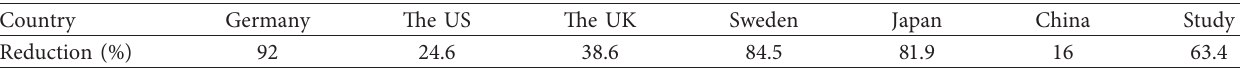
Table 7: Reduction in MSW.